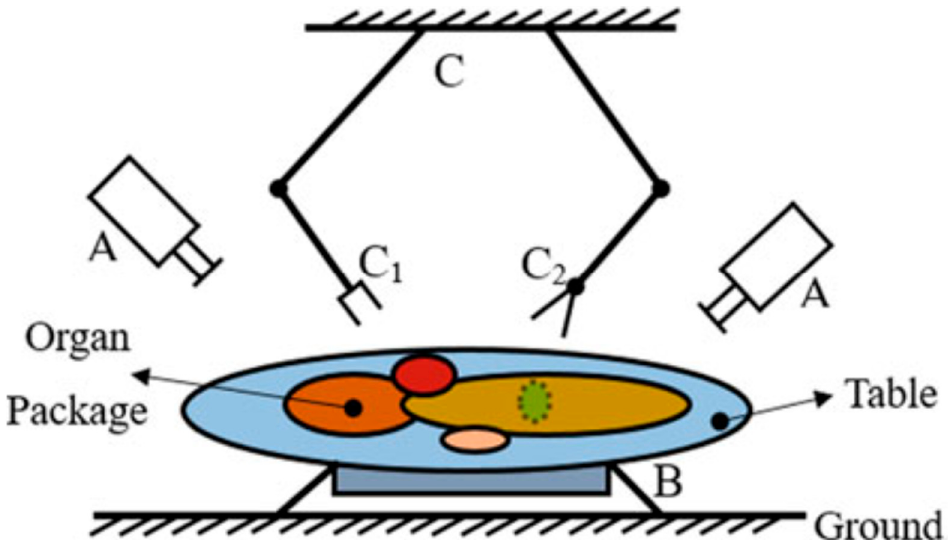
Figure 3. A robotic system for ovine offal harvesting. (A) Machine vision (camera); (B) a sorting device; (C) a dual-arm robot; (C1) a vacuum gripper; (C2) a specific cutting device [40] (From Zhang et al. Discussion of Soft Tissue Manipulation for the Harvesting of Ovine Offal. Reprinted with permission of Springer Nature, London, Copyright © 2021).